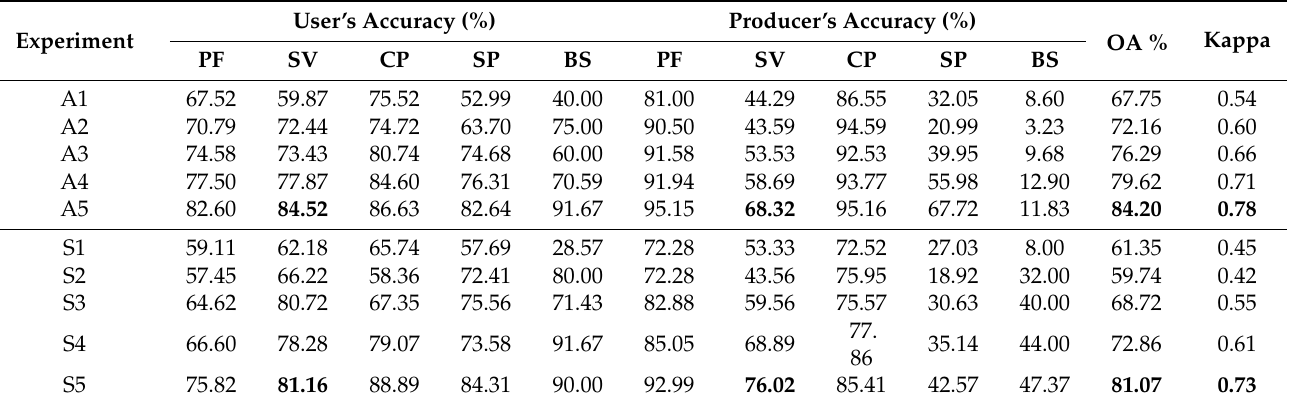
Table 3. Overall accuracy (OA) and Kappa coefficient for the Random Forest classification experi- ments involving ALOS/PALSAR-2 and Sentinel-1 data sets. PF = primary forest; SV = secondary vegetation; CP = clean pasture; SP = shrubby pasture; BS = bare soil. See details of the experiments in Table